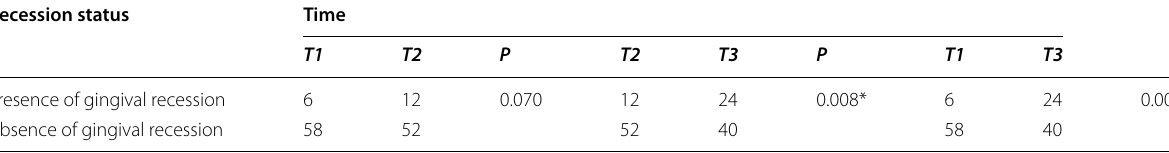
Table 4 Interphase changes in the frequency of mandibular incisor gingival recession (McNemar’s tests) Recession status